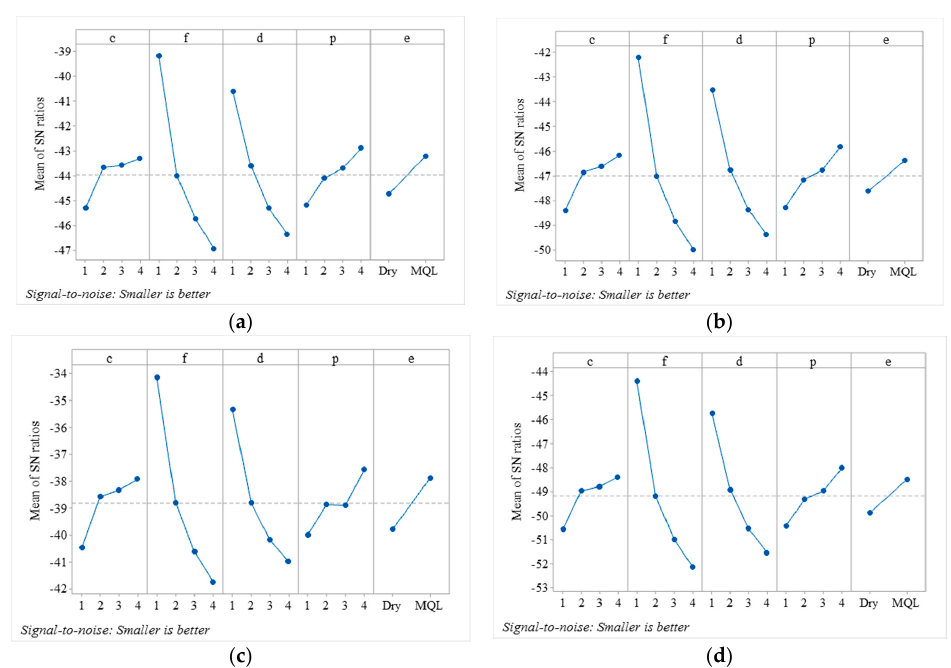
Figure 5. Main effect plot for means of Signal to noise ratio of components of cutting forces ( a ) feed force ( b ) tangential force ( c ) radial force ( d ) resultant force. Materials 2020 , 13 , x FOR PEER REVIEW